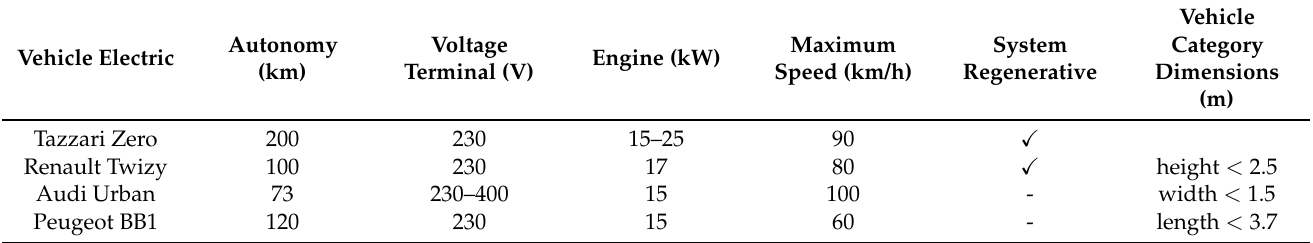
Table 1. Category L7e-C EV